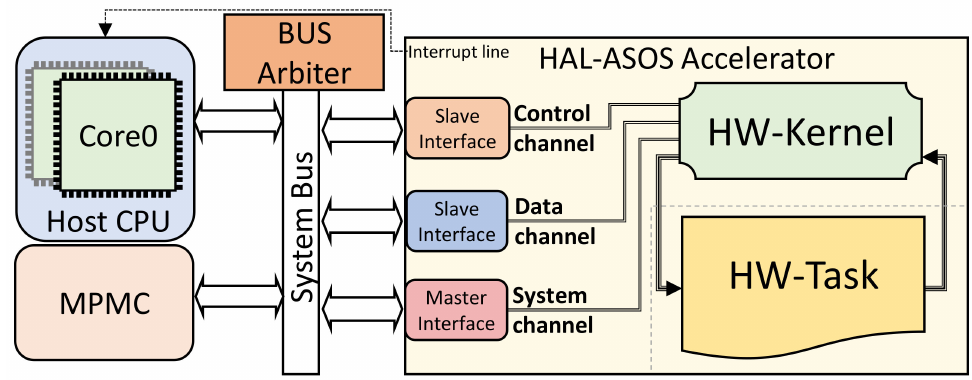
Figure 2. HAL-ASOS accelerator model integrated into host